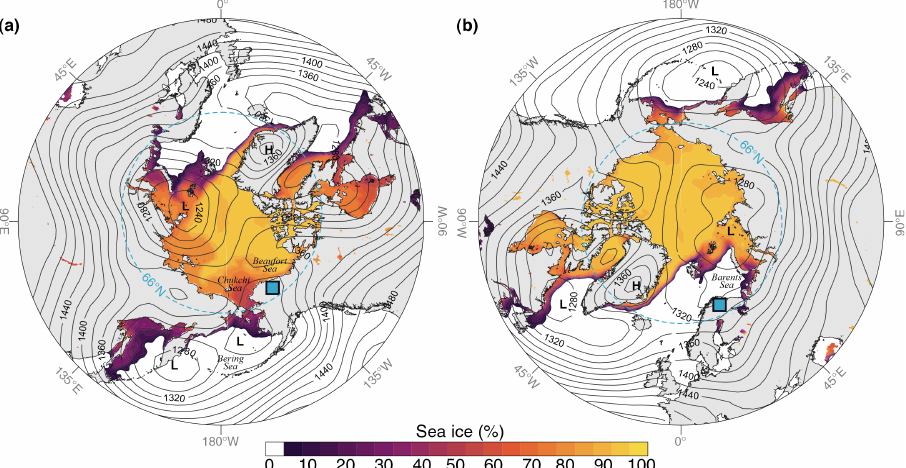
Figure 11. Daily mean climatology composites of the snowfall sampling days at ( a ) Imnavait and ( b ) Pallas (blue squares) during the winter 2018–2019 measurement campaign. Contour lines depict mean 850 mb geopotential heights with the dominant low (L) and high (H) pressure centers [89], and the shaded region represents daily mean composited sea ice concentration during the corresponding snowfall sampling days [90]. The dashed blue circle depicts the Arctic Circle at ~66 ◦ N. Sampling dates used to construct the composite maps are given in Table